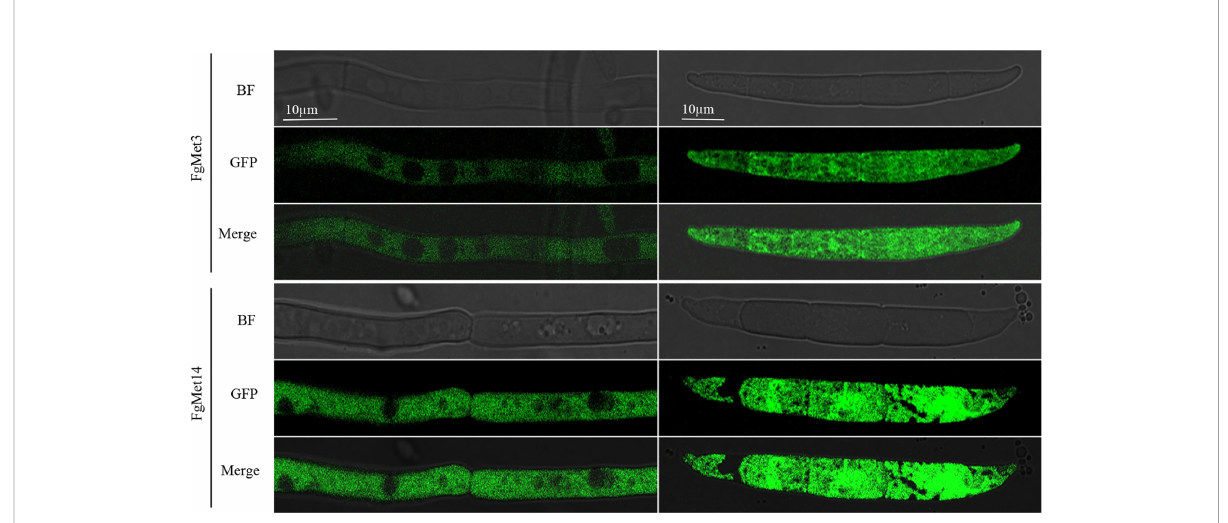
FIGURE 11 Subcellular localization of FgMet3 and FgMet14. FgMet3 and FgMet14 were localized to the cytoplasm. All strains were incubated in YEPD for 12-24 h and MBL for 3 d to obtain mycelium and conidia.